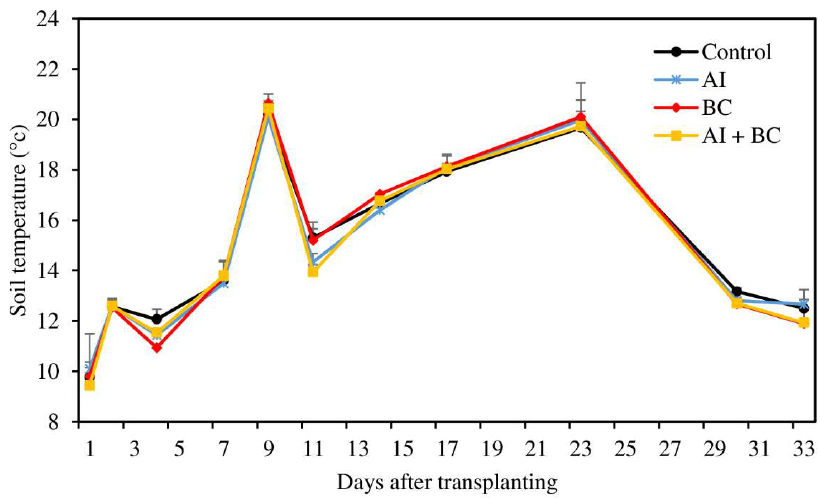
Figure 1. Variation in soil temperature during growing season of komatsuna. Error bars indicate standard deviation ( n = 3). AI: aerated irrigation; BC: biochar.